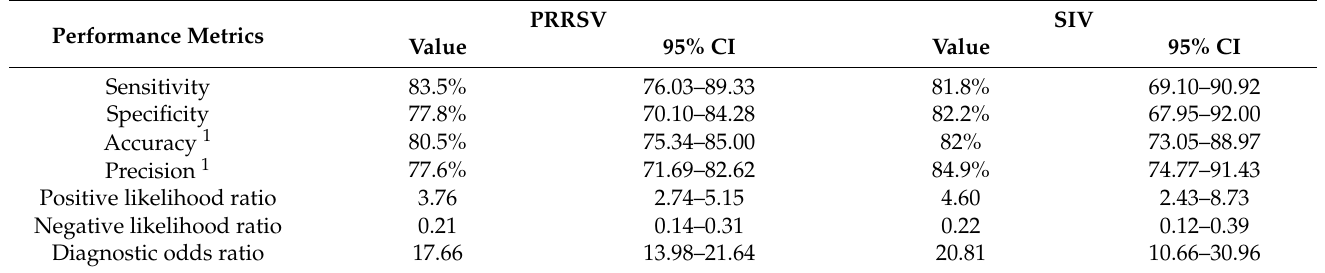
Table 4. Performance metrics of the novel POC device for the PRRSV and SIV functionalized sen- sors.